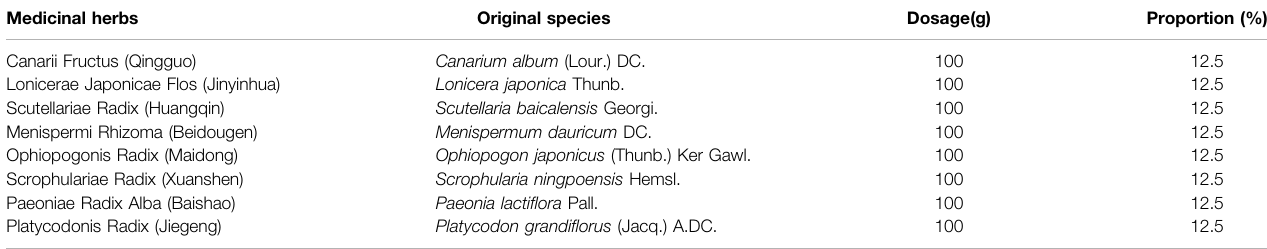
TABLE 1 | The proportion and dosage of herbal materials listed in the prescription of lab-made and commercial Qingguo Wan according to the Chinese Pharmacopoeia. Medicinal